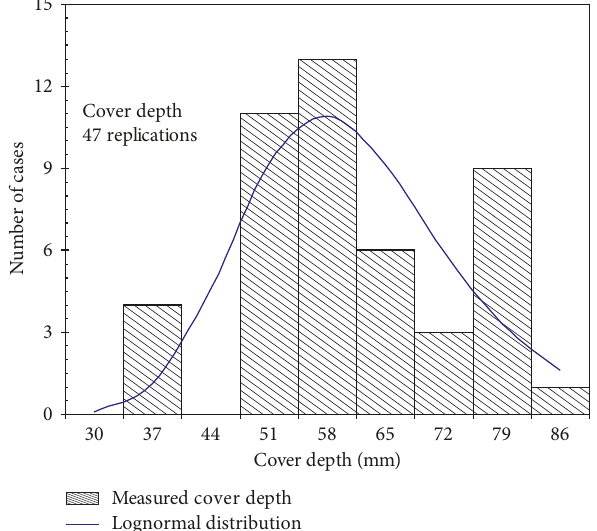
Figure 7: Distribution of concrete cover depth values obtained from RC